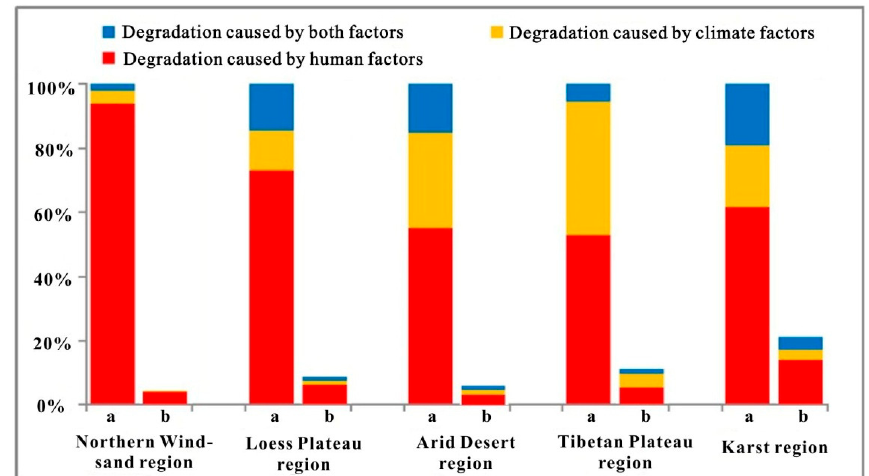
Figure 6. Statistics of vegetation degradation caused by different factors in the whole areas “a” and the NPP a significantly changed areas “b” of five ecologically vulnerable regions from 2000 to 2015.